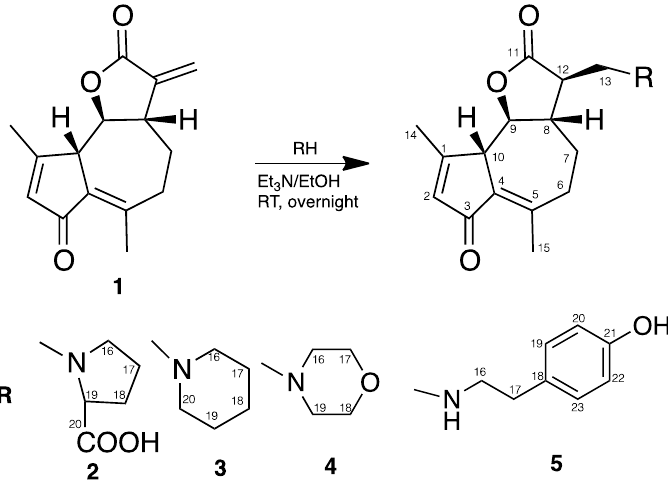
Scheme 1. Synthesis of the amino derivatives of compound 1 .